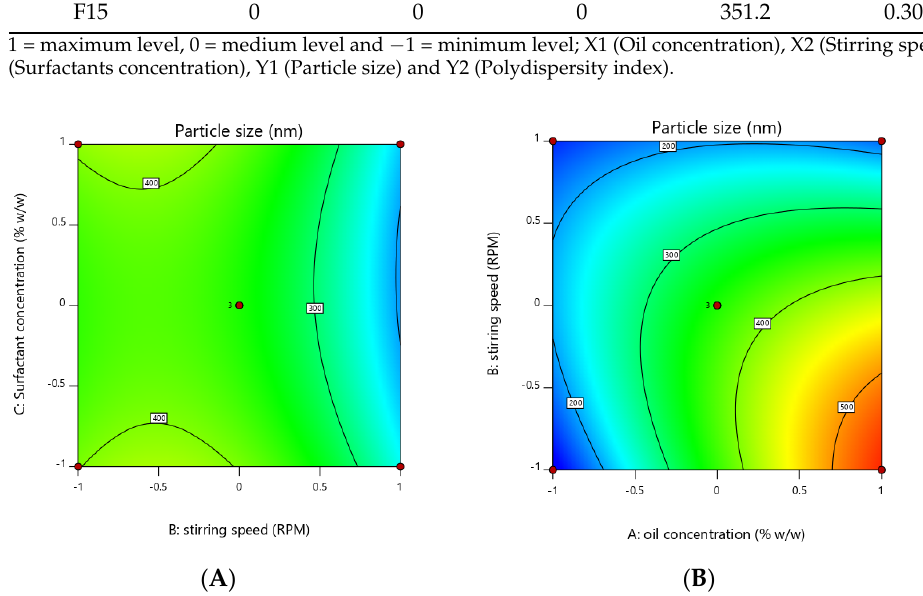
( C ) Figure 2. Contour plot showing the effect of independent factors X1 (oil concentration), X2 (stirring speed) and X3 (surfactants concentration) on responses Y1 and Y2. ( A ) effect of surfactant concen- tration and stirring speed on particle size ( B ) effect of stirring speed and oil concentration on particle size. ( C ) effect of surfactant concentration and oil concentration on particle size. ( A )